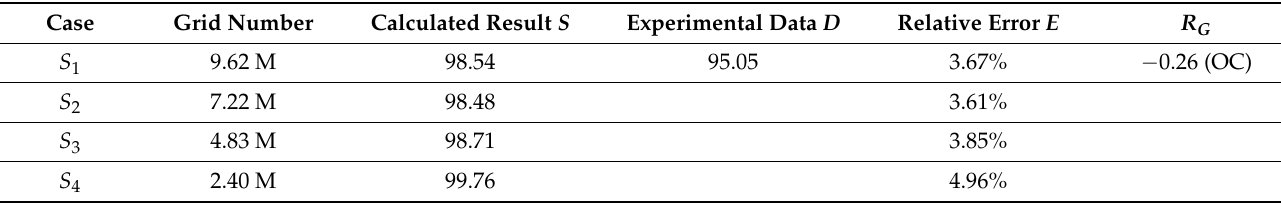
Figure 7. Convergence of the total resistance. Table 2. Results of grid uncertainty analysis.